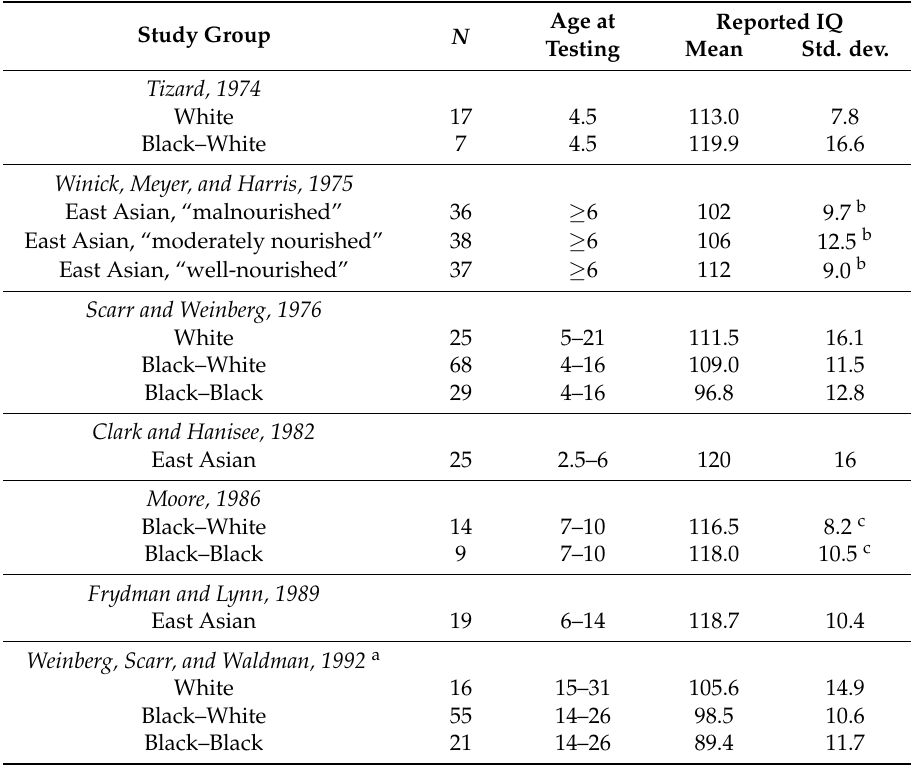
Age at Reported IQ Testing Mean Std. dev.